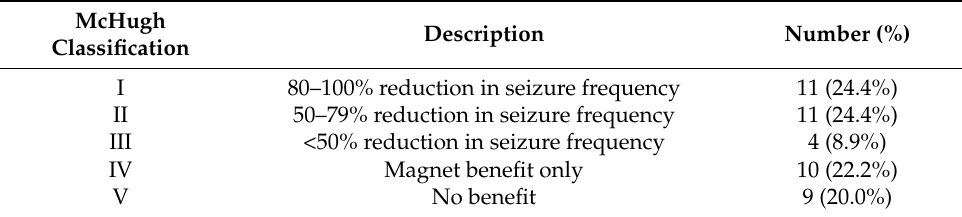
Table 3. Outcome of seizure control by modified McHugh classification at the final follow-up.